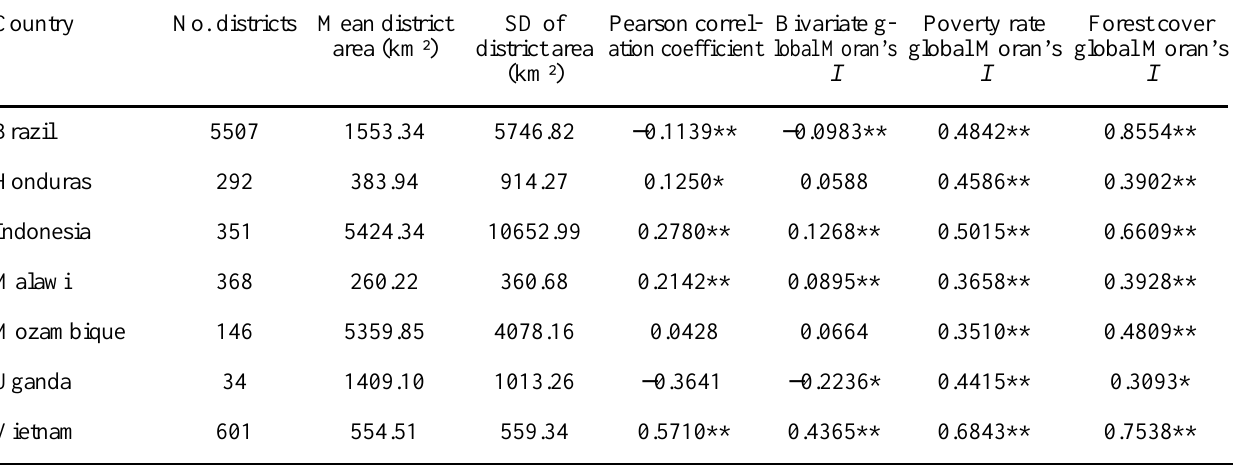
Table 1. Pearson correlations and bivariate and univariate global Moran’s I calculations for poverty rate and forest cover data from seven case study